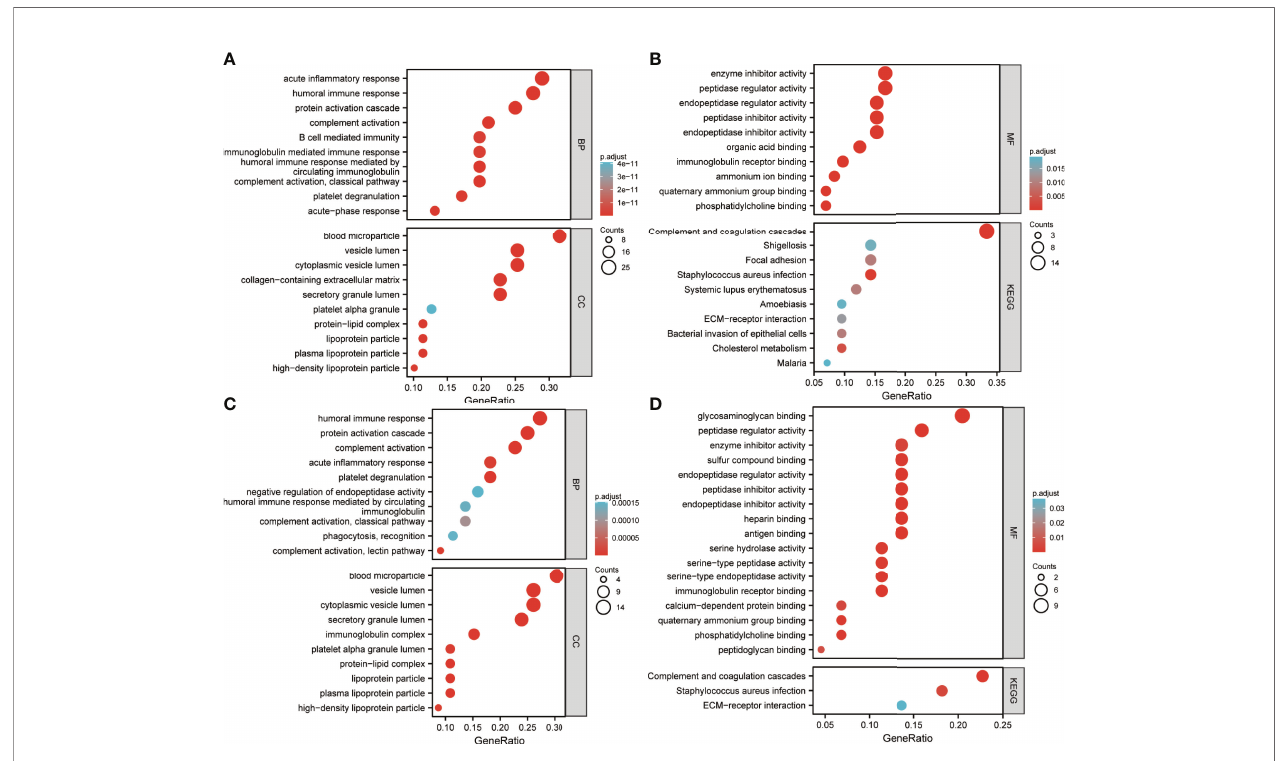
FIGURE 4 | Gene Ontology (GO) and Kyoto Encyclopedia of Genes and Genomes (KEGG) functional enrichment analyses of HC vs. LA-NPC and pre-EFF vs. pre-NEFF DEPs. The ordinates in A − D represent enriched GO functional classi fi cation terms, including biological process (BP), cellular component (CC) and molecular function (MF) categories, and KEGG pathways. The abscissa represents terms enriched for DEPs under each functional classi fi cation. The size of the bubble represents the number of DEPs, and its colour indicates the signi fi cance of the enriched terms based on Fisher ’ s accuracy. The p -value was calculated by Fisher ’ s Exact test, and the colour gradient represents the magnitude of the p -value, from cyan (large) to red (small). (A, B) Functional enrichment analysis results for DEPs between HC and LA-NPC groups. (C, D) Functional enrichment analysis results for DEPs between pre-EFF and pre-NEFF